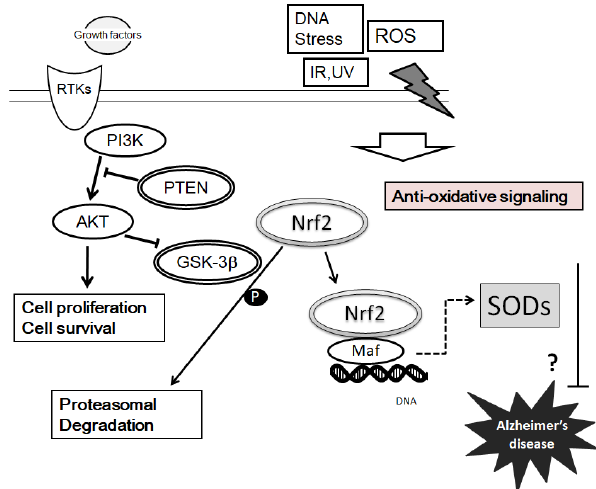
Figure 3. Implication of SODs in the neuroprotection against Alzheimer’s disease via the signaling of PI3K/AKT/PTEN/GSK-3β pathway, and examples of molecules known to act on the regulatory pathways are shown. PI3K/AKT/PTEN/GSK-3β pathway and SODs may contribute to neuroprotection in AD. Hammerheads mean inhibition. Note that some critical events have been omitted for clarity